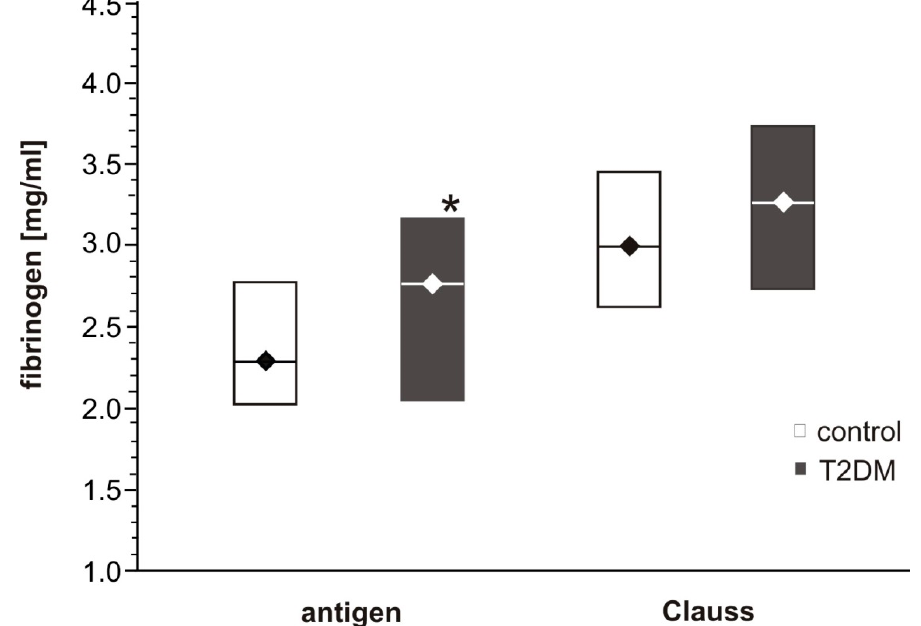
Figure 3. Fibrinogen concentrations in plasma from T2DM patients and control subjects. Data shown as the median (horizontal bar) and the lower – upper quartile range (box); n = 24 for DM, n = 20 for control. The concentration of fibrinogen antigen was significantly higher in DM plasma (grey boxes) compared to control plasma (white boxes) (* p < 0.05 by two-way ANOVA for repeated measures and the bootstrap-boosted Student t test).